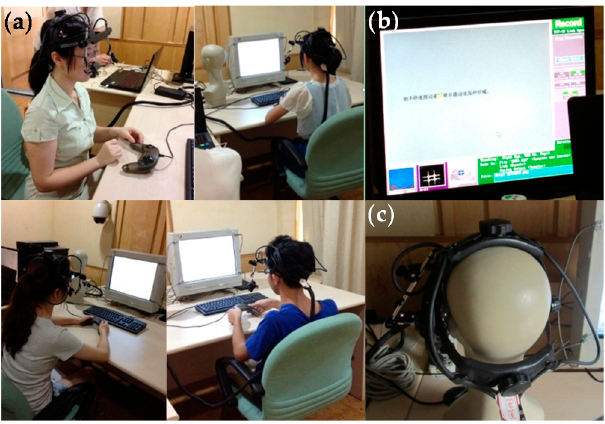
Figure 4. Experimental process: ( a ) Participants doing the eye-tracking experiment in the lab; ( b ) The calibration process of the eye-tracking sensors; ( c ) The eye-tracker helmet (EyeLink II) used in this experiment.